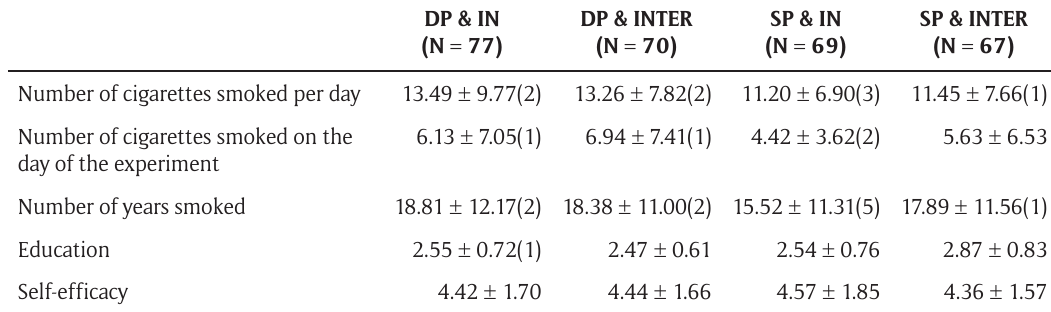
Table 5: Mean scores and standard deviations on secondary variables of Study